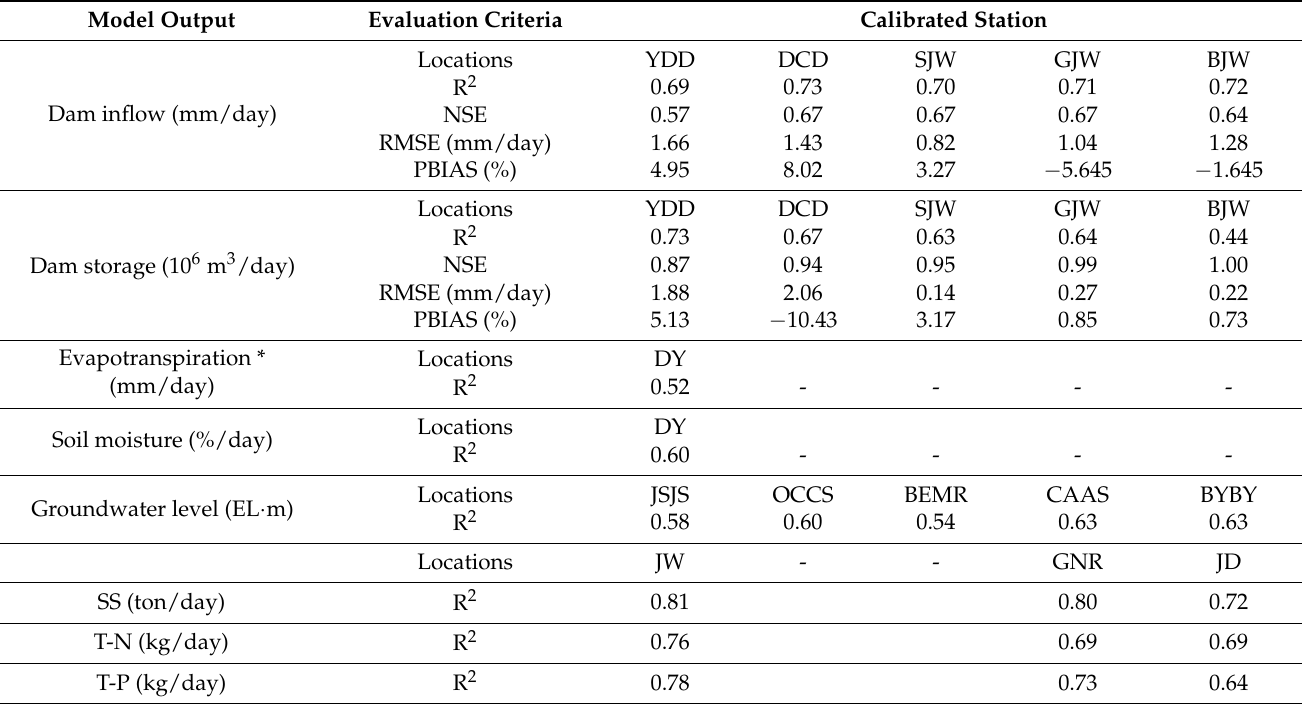
Table 1. SWAT evaluation results for